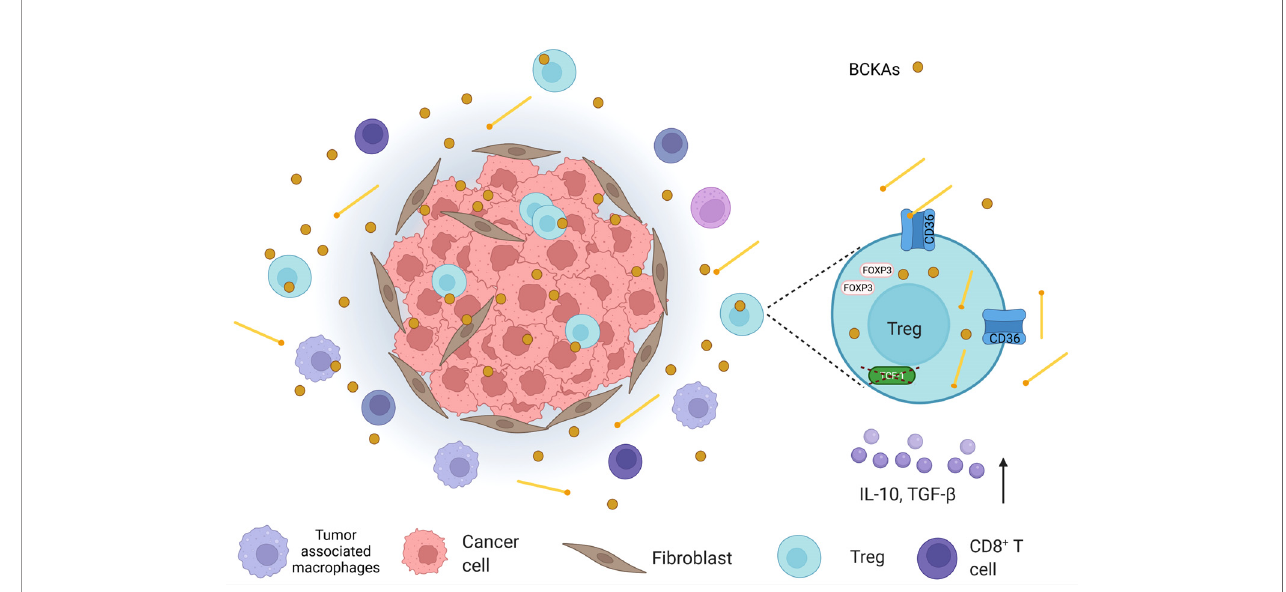
FIGURE 4 | Anillustrationthatshowsthetumormicroenvironment(TME)inwhich, apartfrom cancer cells,cancer-associated fi broblasts,tumor-associatedmacrophages, CD8 + Tcells,andregulatoryT cells (Tregs) arefound.InTME,branched-chainketoacids(BCKAs), whichareformedbythedeaminationofbranched-chainaminoacids(BCAAs), arepresent.Inaddition, Tregsdemonstrate highlevelsofCD36expressioninTME. Considering thefactthatCD36 mediateslipiduptakeandTregs utilizelipidoxidationas a meansofenergysource; theymayobtainlipidsfrom theextracellularspace.Highlipiduptake, inturn,canattenuateBCAAcatabolism attheBCKAstage, whichmayalso increaseBCKAsinTME. Moreover, intratumoralTregsweredepictedto possesslower transcriptionfactor Tcellfactor 1(TCF-1)(incolorectalcancer).Loss ofTCF-1may contribute tobothCD36alterationsandperturbationinBCAAcatabolism inTregs, whichmayaffecttheir